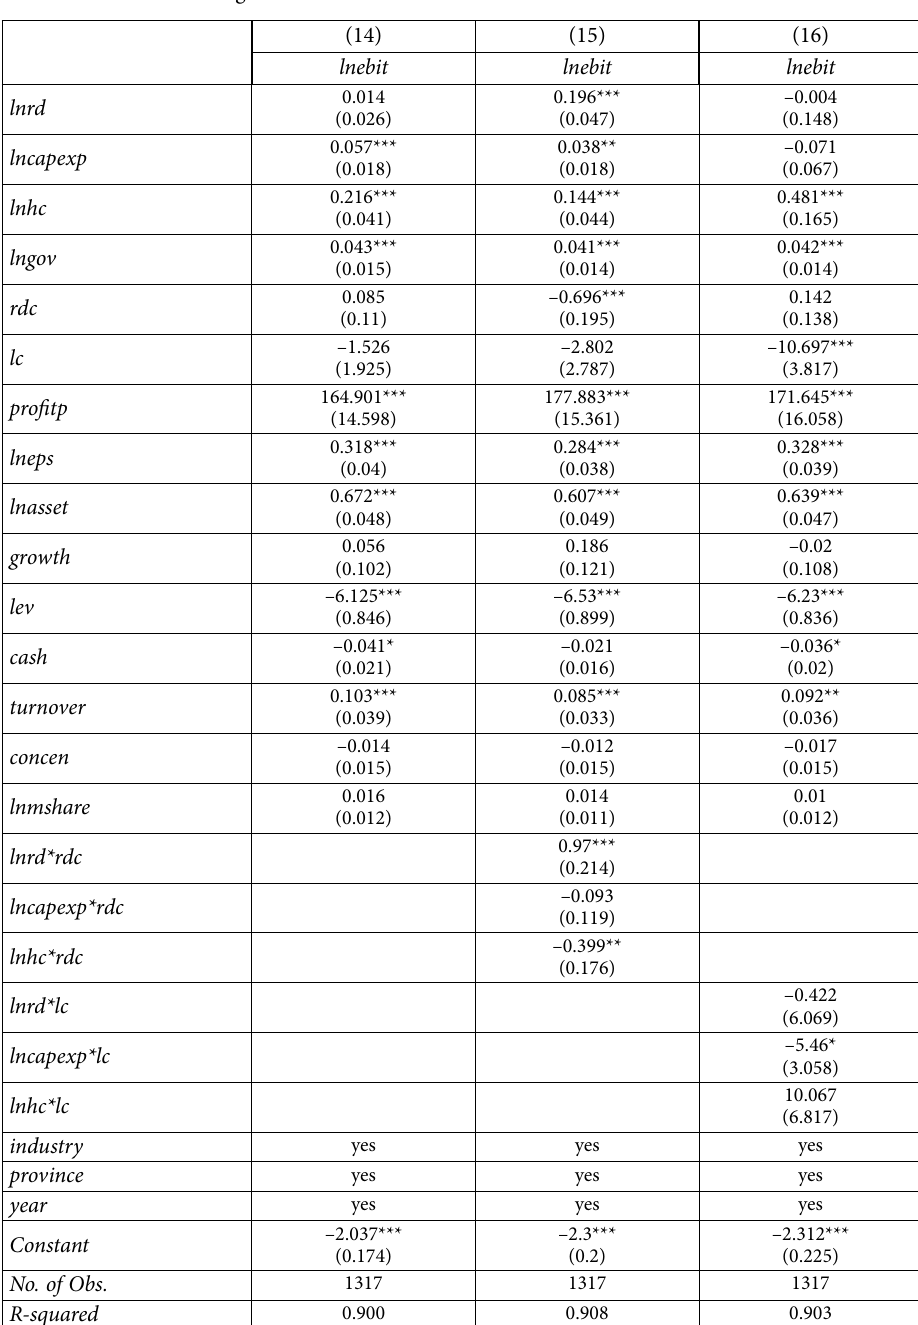
Table 2. Results of OLS